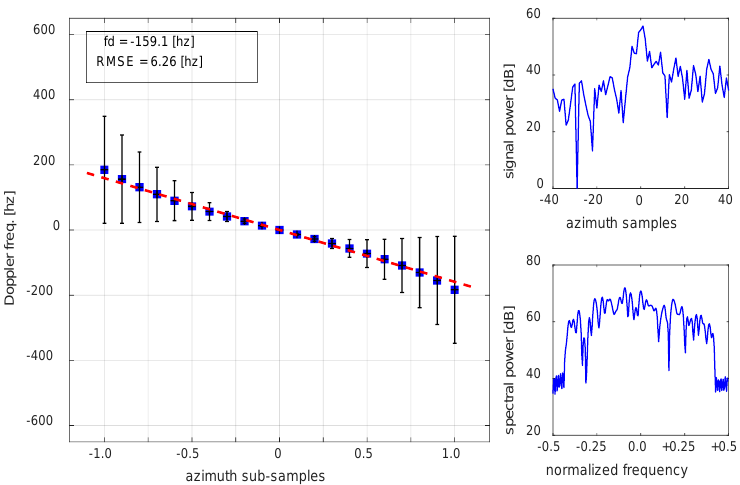
Figure 5. The SAR measured Doppler frequency of the high-speed ship B’ in Figure 1b. The corresponding range velocity is 18.3 ± 0.72 km/h. The PSLR and SCR of the target are − 7.9 dB and 23.9 dB, respectively. The estimated range velocity by this method was confirmed by measuring the azimuth distance of the target, shifted from the apex of wake in the image.